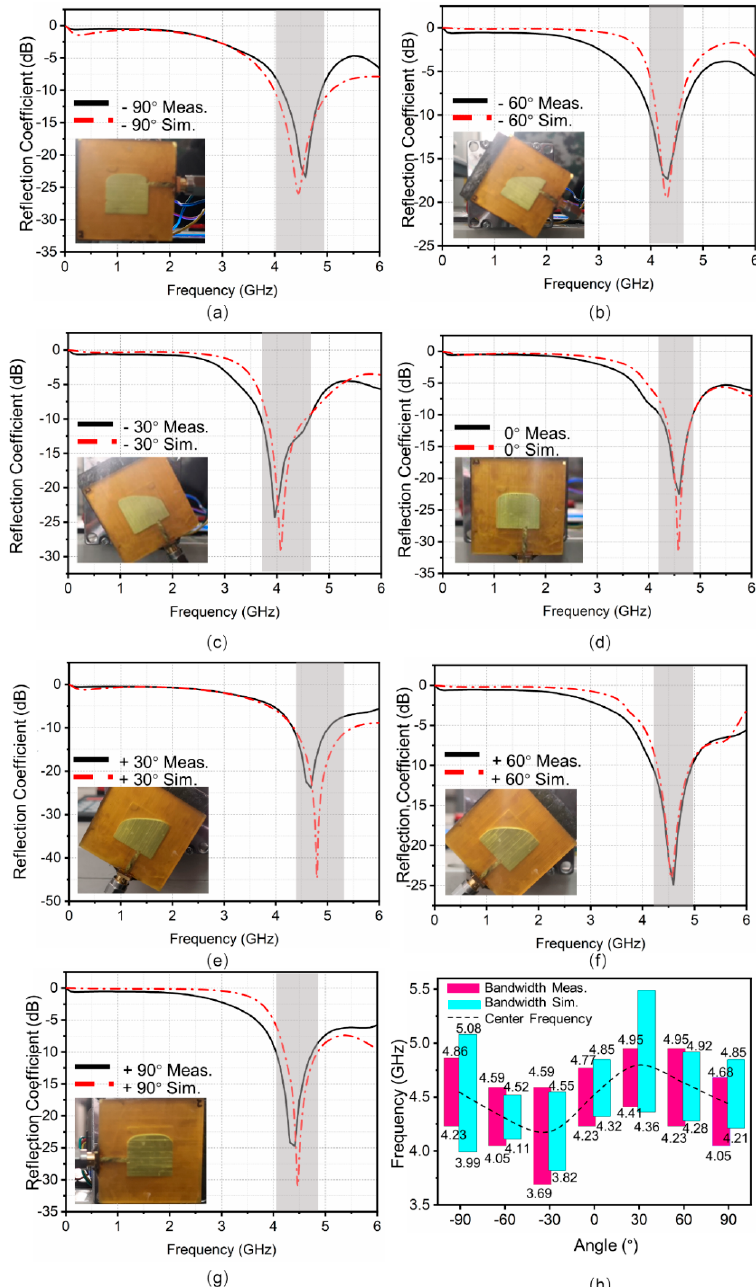
Figure 7. ( a – g ) Simulation and measurement results of the reflection coefficients of the antenna for various frequencies, where the rotation angle is increased from − 90° to +90° in steps of 30°. ( h ) The obtained impedance bandwidth by simulations and measurements for different rotation angles.